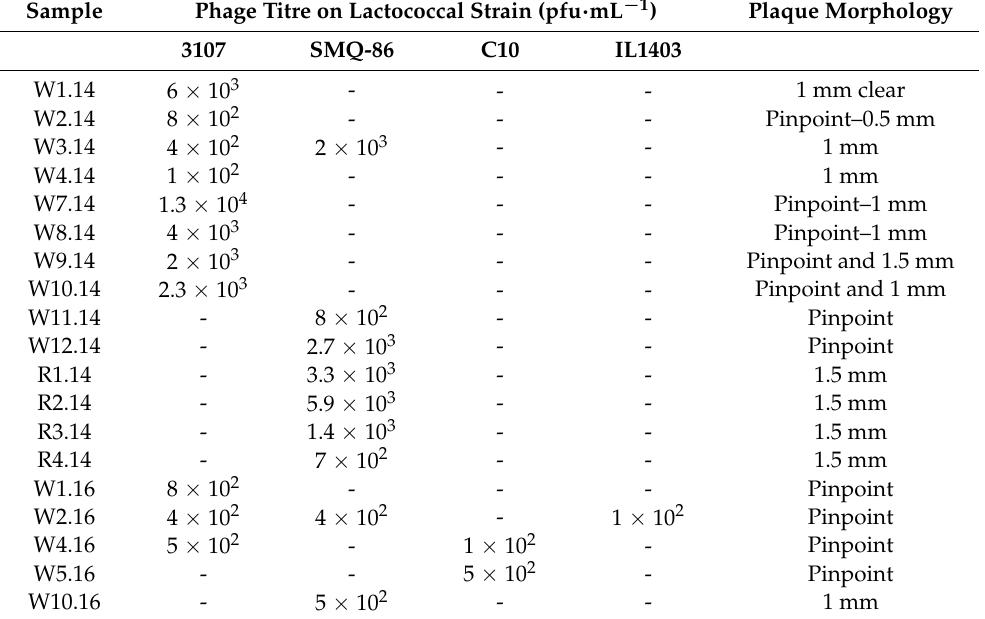
Table 3. Phage titres on strains that were sensitive to phages and associated plaque